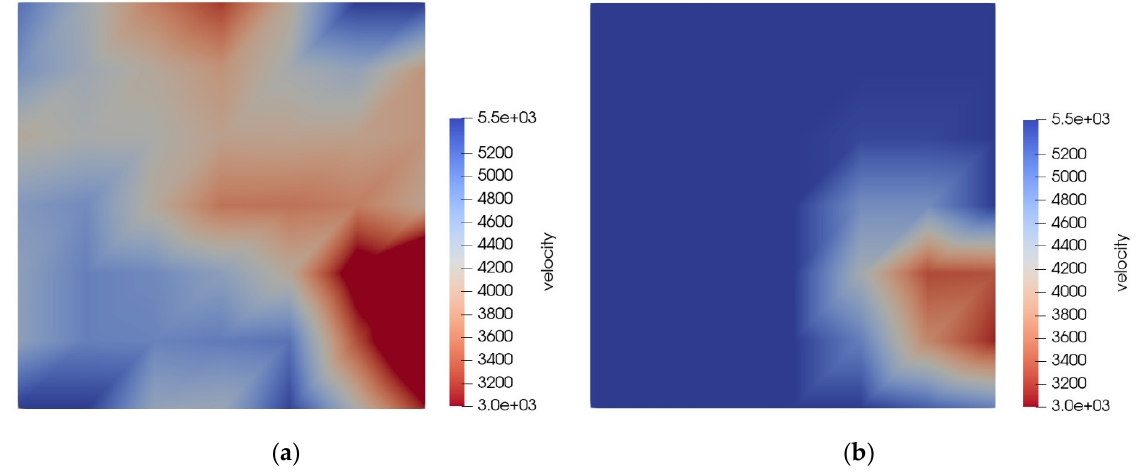
Figure 17. Reconstructed velocity distribution: ( a ) result by the SIRT algorithm adopting 36 events; ( b ) result by the LASSO algorithm adopting 18 events.